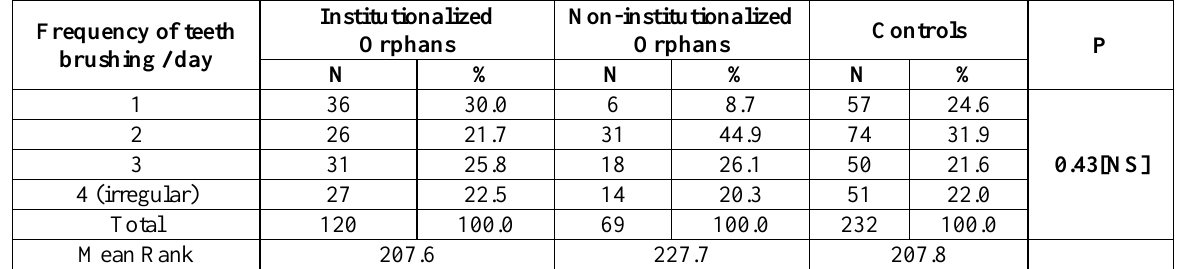
Table 2: Differences in teeth brushing frequency /day among the groups.